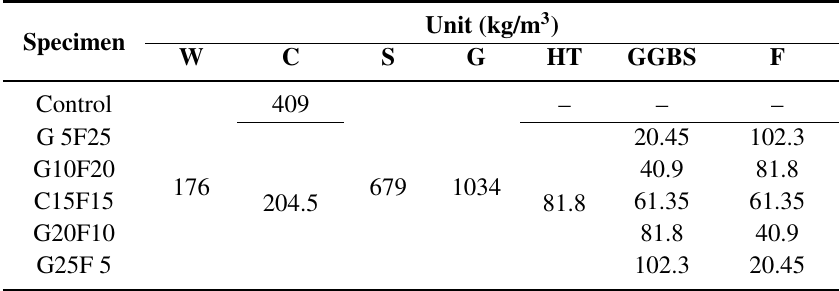
Table 4. Mix proportion of Hwangtoh concrete (W/B 45%, S/a 40%, HT 20%). Specimen